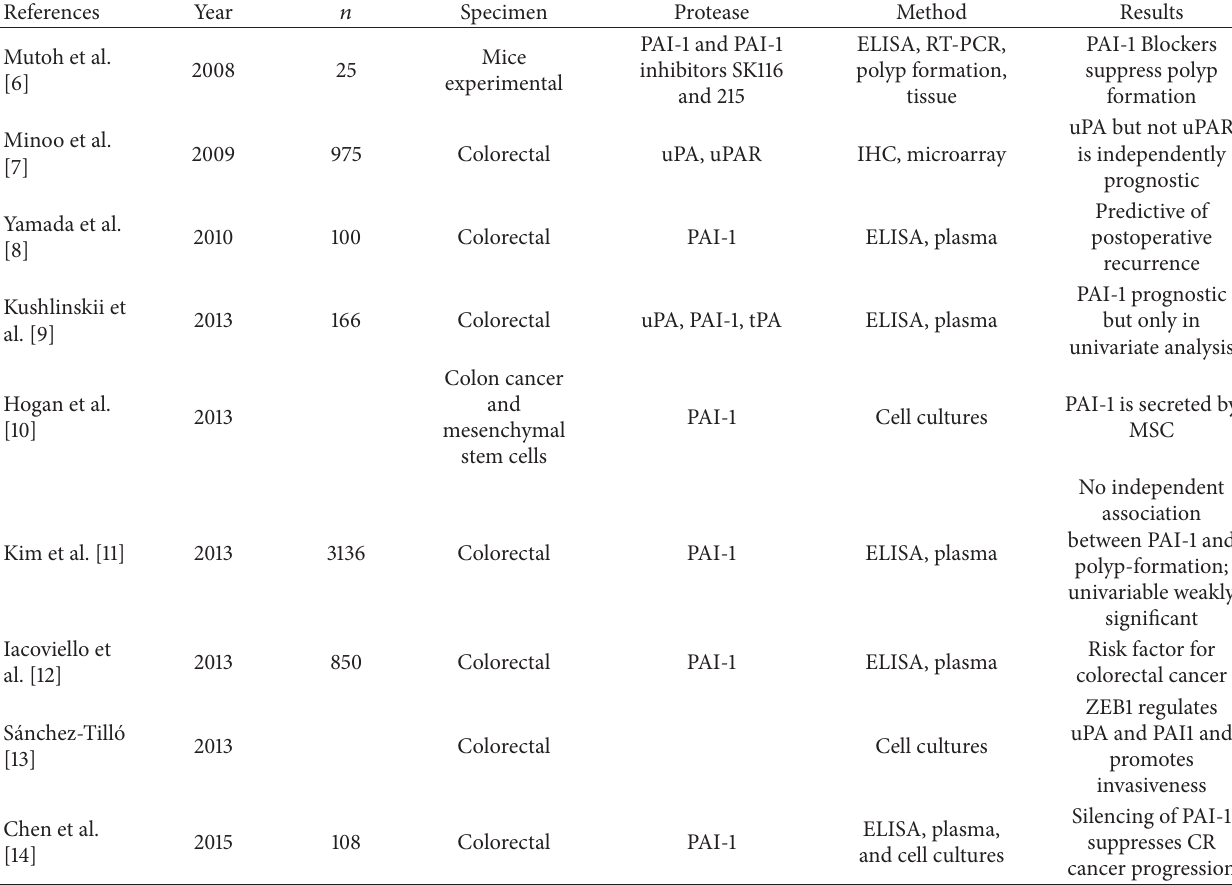
Table 4: Previous studies investigating the prognostic role of uPA and PAI-1 in colorectal cancer.